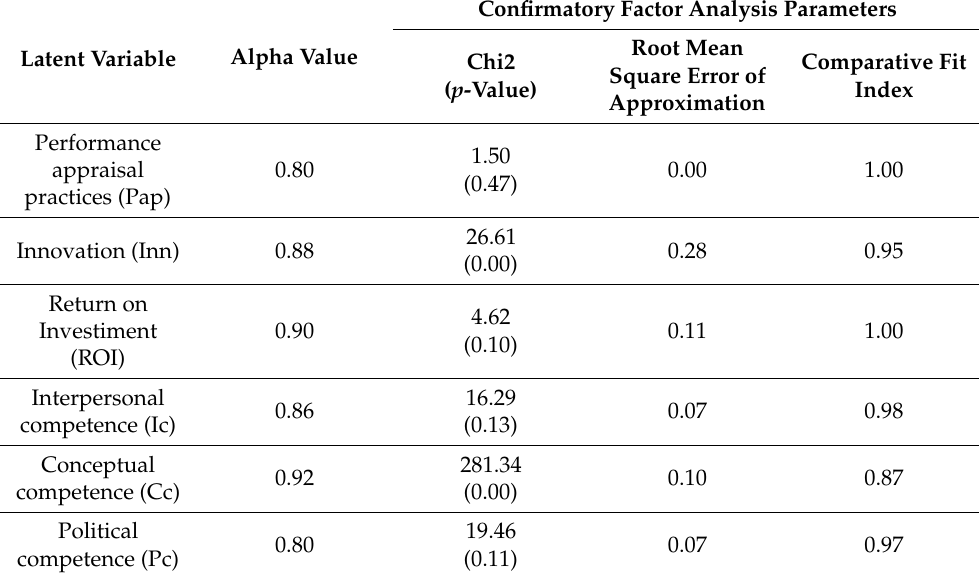
Table 2. Cronbach alphas and Confirmatory Factor Analysis